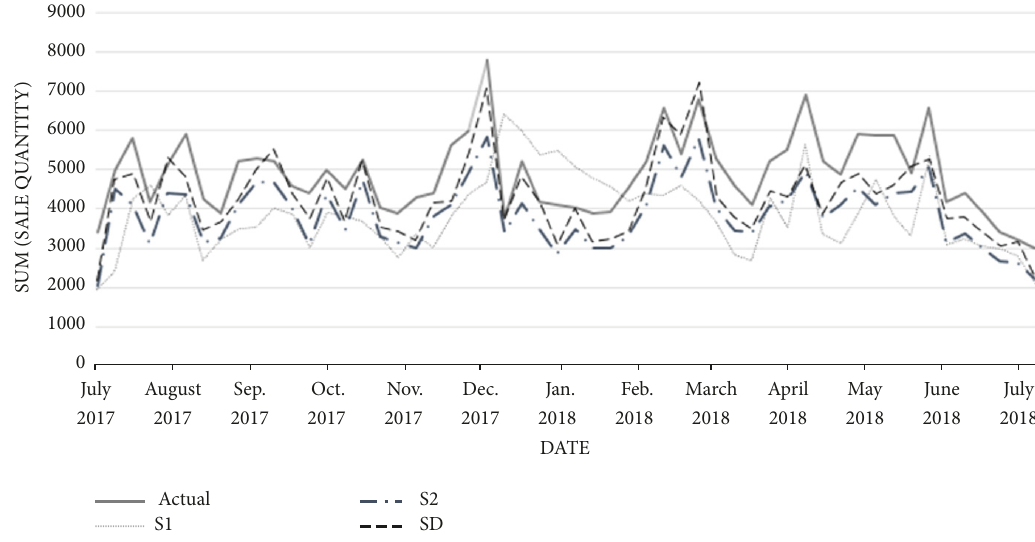
Figure 5: Accuracy comparison among integration strategies for one sample product